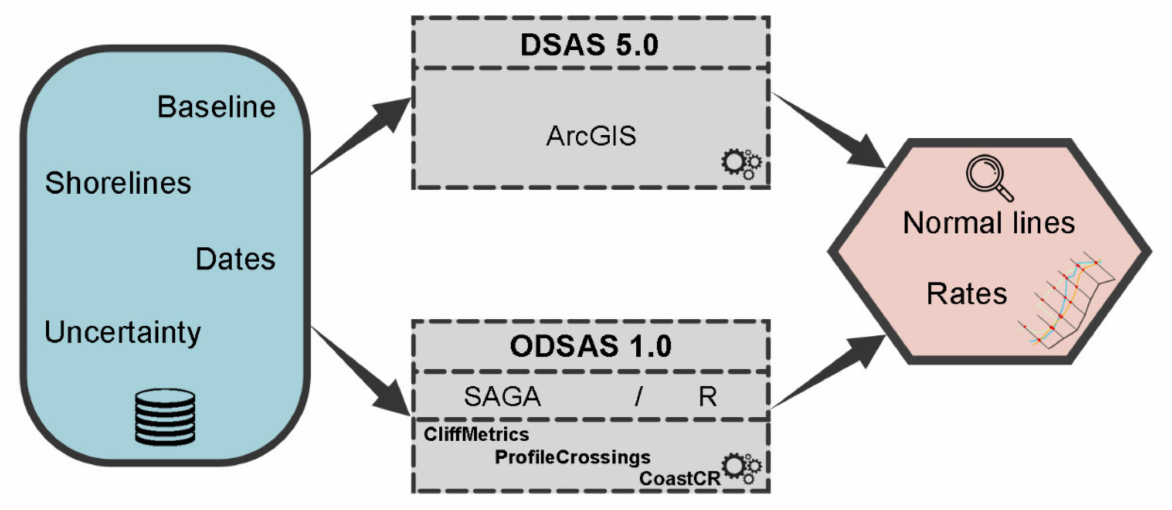
Figure 1. Input and outputs scheme of the DSAS and ODSAS